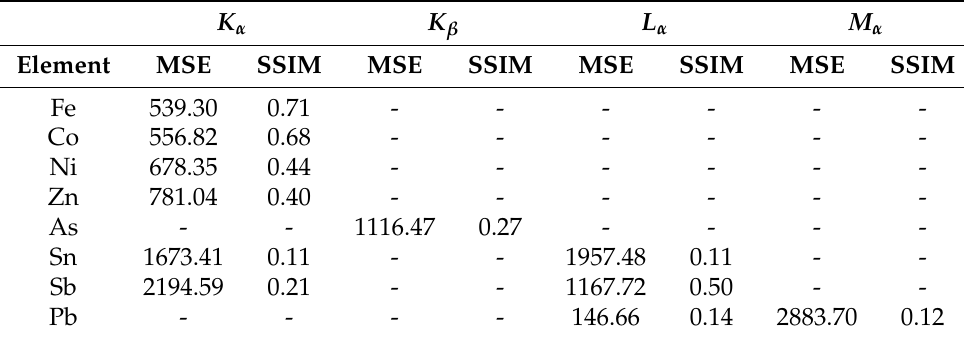
Table 1. Image scores between the Modular Scanner and M4 Tornado